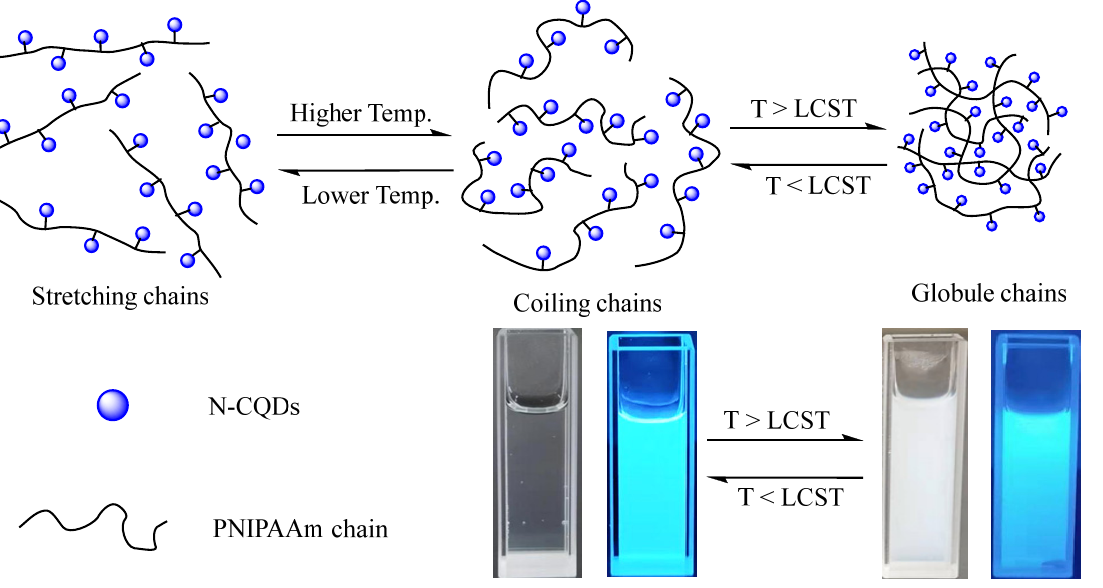
Scheme 2. The mechanism of PL intensity variations of poly-N-CQDs to thermo-responsiveness.